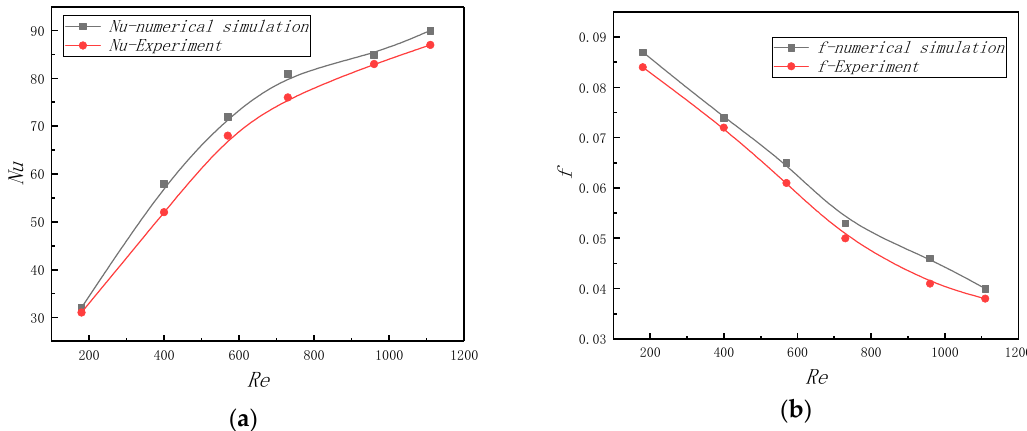
Figure 4. Comparison of simulation result with experiment data for average Nusselt number and friction factor.( a ) The curve of the Nusselt number ( b ) The curve of the friction factor